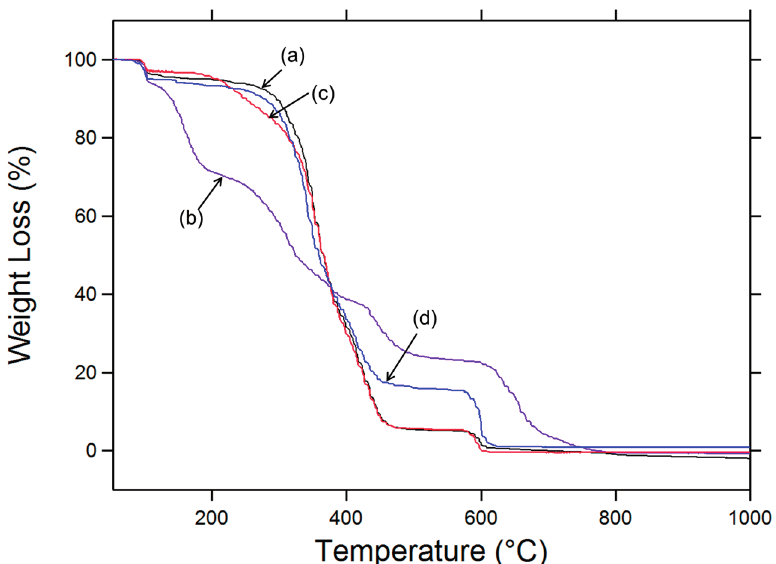
Figure 5. Thermal stability analysis (TGA) curves of ( a ) unmodified PVA; ( b ) PVA-Ts; ( c ) PVA-N 3 and ( d ) PVA-NH 2